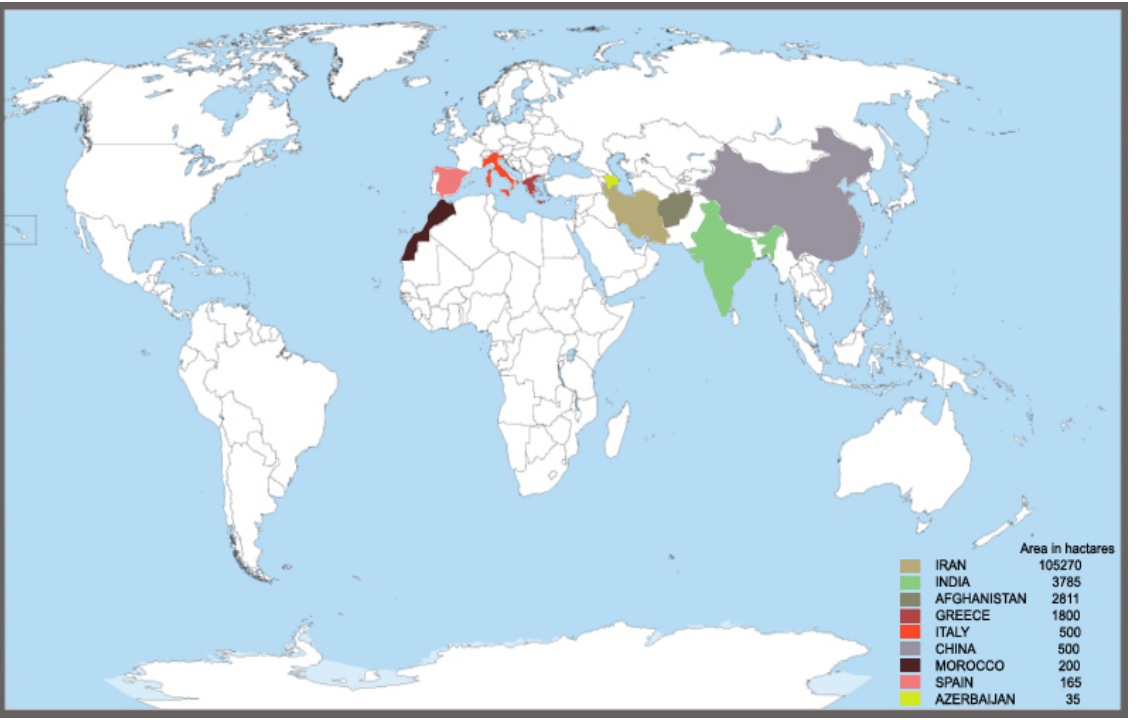
Figure 2. Major saffron growing countries of the world.